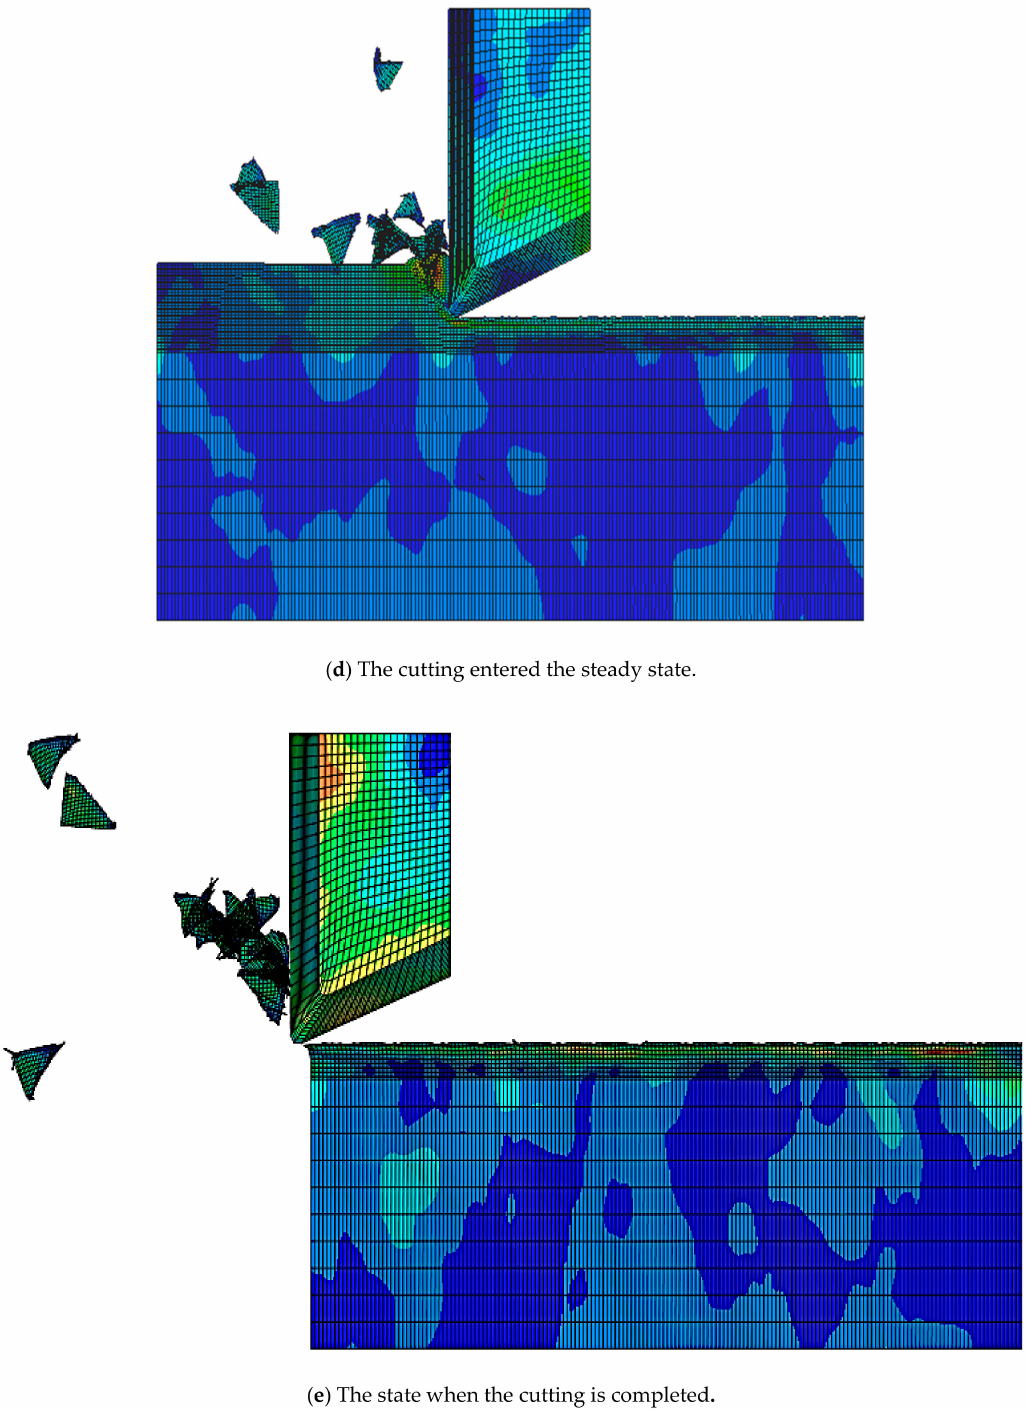
Figure 8. Stress and chip formation of cast